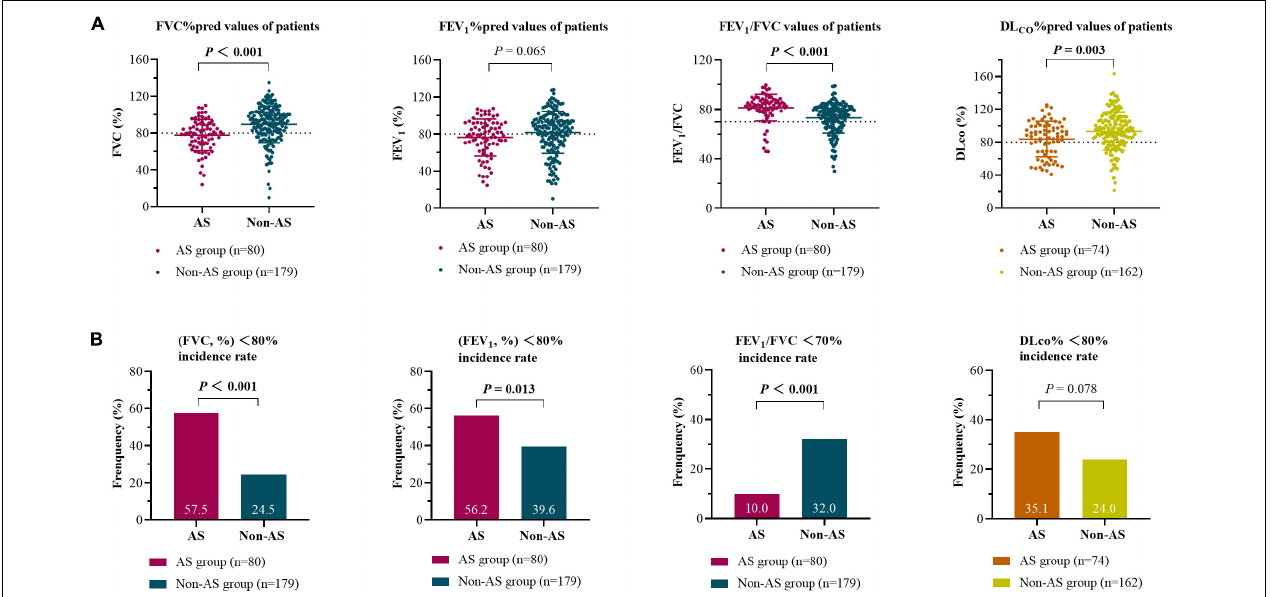
FIGURE 2 | Baseline lung function (measured/predicted) for silicosis with AS group and non-AS group (A) and the incidence of pulmonary dysfunction in the two groups (B) at the first registration. The area above the dotted line represent the normal ranges of the indices. The differences between groups were analyzed by Student’s t -tests (A) and Chi-square tests (B) . FVC, forced vital capacity; FEV 1 , forced expiratory volume in 1 s; DL CO , diffusing capacity of the lung for carbon monoxide.